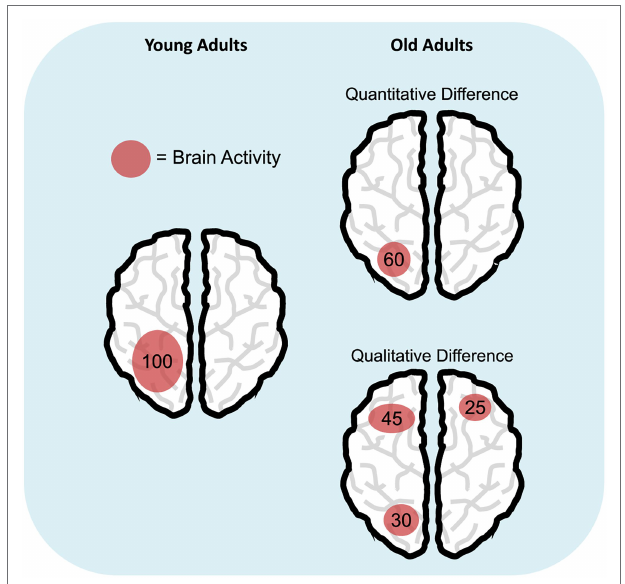
FIGURE 1 | Age-related differences in cognitive resource allocation. The schematic representations illustrate the hypothesis of quantitative (i.e., reduction; top right panel) versus qualitative difference (bottom right panel) in the deployment of cognitive resources in aging, compared to young adulthood (left panel). Numbers represent a hypothetical amount of engaged cognitive resources and how they are distributed during a specific